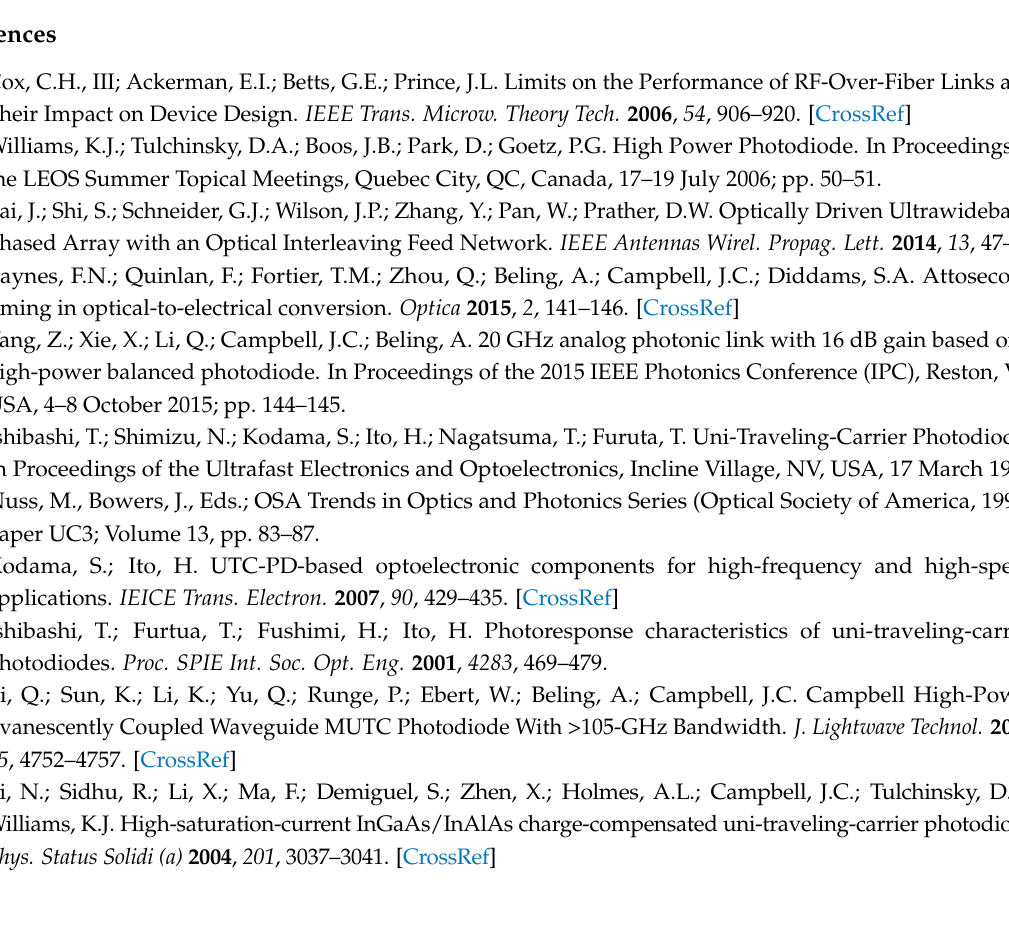
Figure 17. RF output power versus frequency of PDs for high-power analog applications reported in the literature. Green: normal-incidence PDs on native InP substrate; orange: waveguide PDs on native InP substrate; blue: integrated III-V waveguide PDs on Si; red: integrated Ge waveguide PDs on Si.